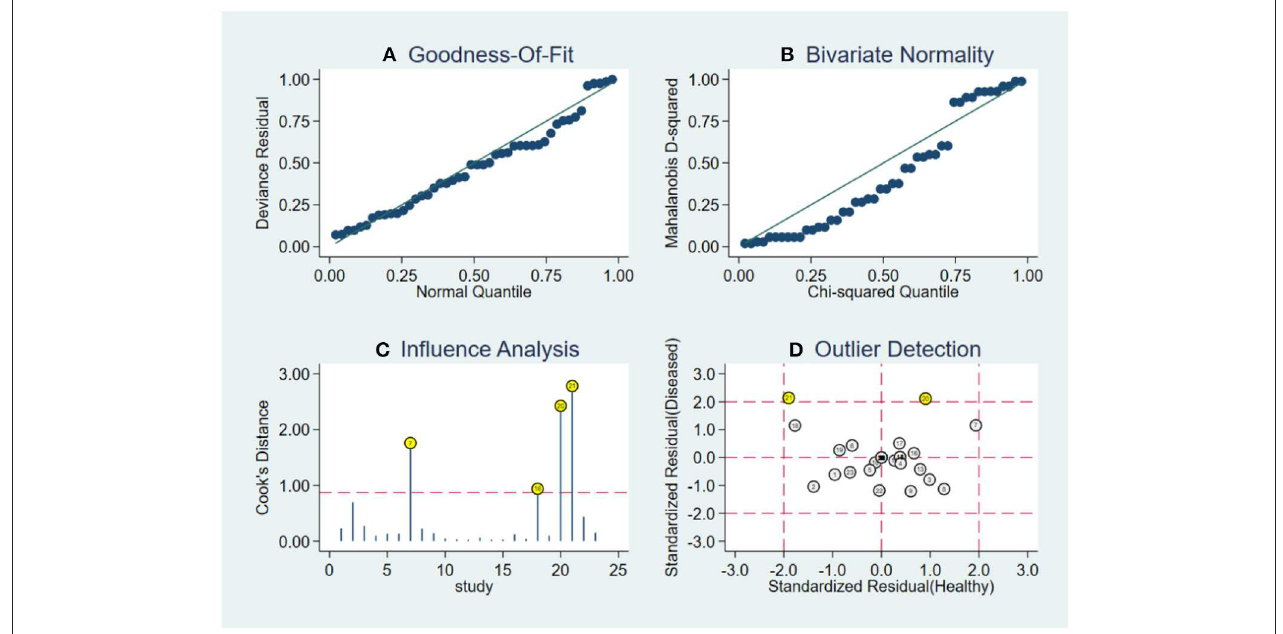
FIGURE 5 | Robustness analysis, influence analysis, and outlier detection. (A) Goodness of fit, (B) bivariate normality, (C) influence analysis, and (D) outlier detection.